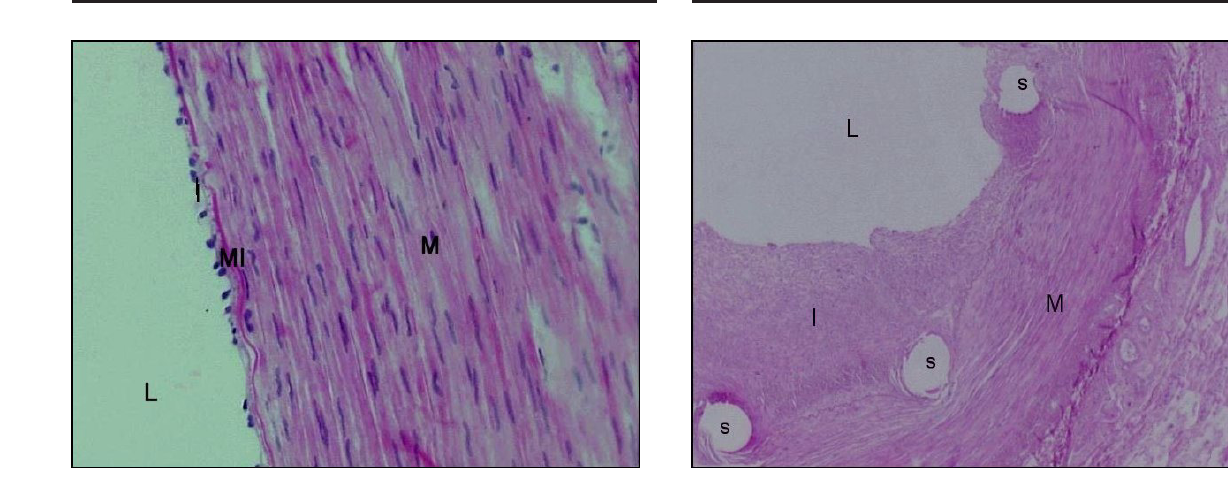
FIGURE 1 - Photomicrograph of normal uninjured LCC artery FIGURE 3 - Photomicrograph of RCC artery of STENT group of a pig. Staining: HE. Original 4 weeks after stent placement. Staining: